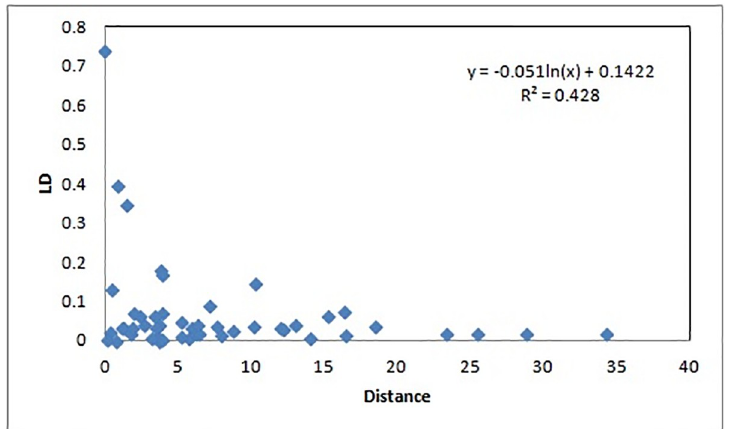
Fig 6. Linkage disequilibrium (LD) decay ( r 2 ) curve plotted against the physical distance (base pairs) between pairs of loci on chromosomes in rice. The decay started in million bp estimated by taking 95 th percentile of the distribution of r 2 for all unlinked